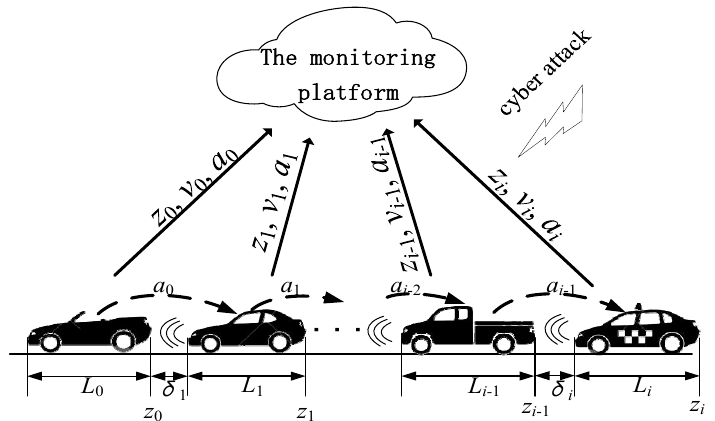
Figure 1. A schematic of intelligent connected vehicle systems with cooperative adaptive cruise control (CACC) and cyber ‐ attack.